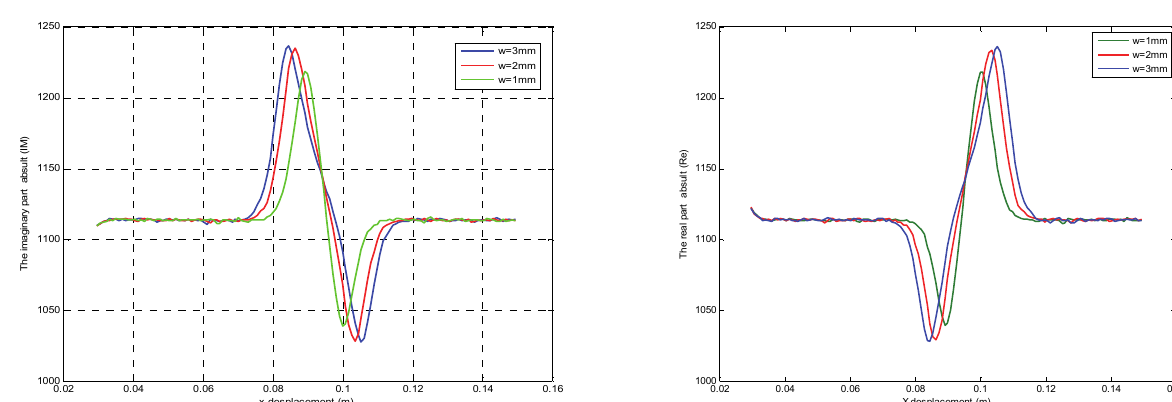
Figure 15: Evaluation of the reactance of the sensor vs. crack width.